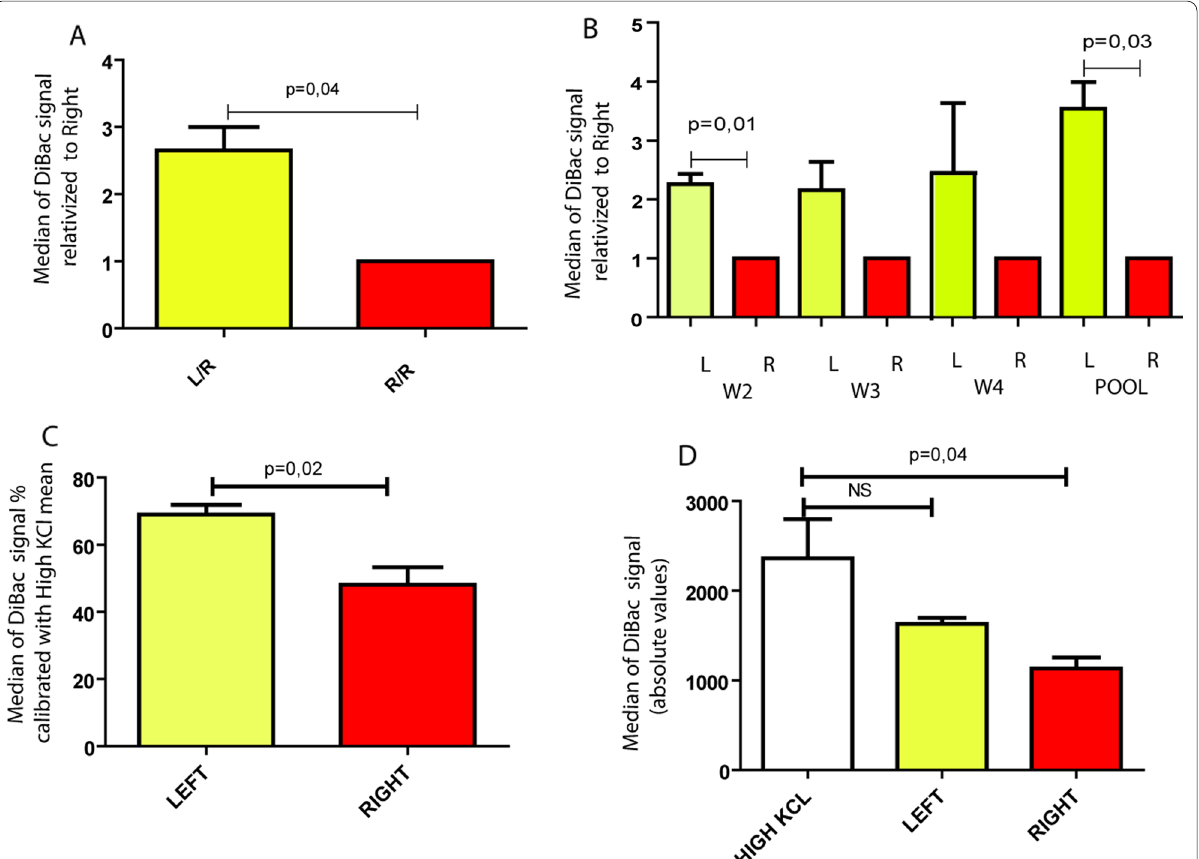
Fig. 5 L/R membrane potential comparison in conditioned MDA-MB-231 cells. A The results are expressed as the L-median of DiBAC 4 (3) fluorescence relativized to R. The histogram shows the L/R and R/R ratio of the signal. The value of R/R ratio is 1. The mean value of L/R ratio is 2.65, N 3 experimental replications (treatments with extracts W2, W3, W4; each with 2–3 technical replications). B Individual analyses of the effect of L/R = normal breast tissue extracts on cells. The results are expressed as the L DiBAC 4 (3) fluorescence relativized to R, as explained for A . The three extracts present increased DiBAC 4 (3) fluorescence in L-treated cells, although not all significant. W2: p NS increased tendency; pool: p 0.03, mean of difference: 2.53. One-sample T-test with hypothetical R value = replicates were performed. C L and R DiBAC 4 (3) fluorescence medians are expressed as percentages of the median fluorescence of high-KCl treated cells. L-treated cells present higher fluorescence as compared to the R ones (unpaired T test, p R treated cells are compared. Only the R-treated ones differ significantly from the completely depolarized (One-way ANOVA p 0.0037). Raw data are available in Additional file 3: Table =